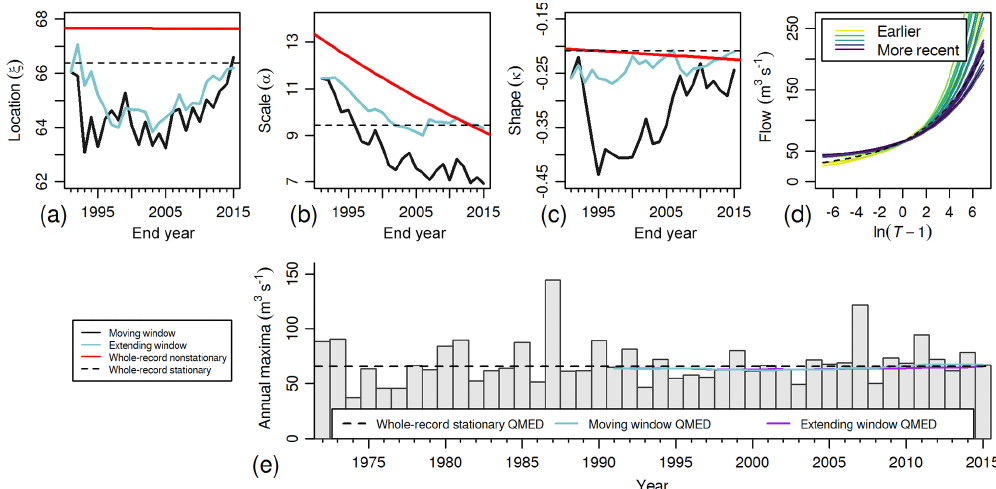
Figure 6. Example of results from fitting stationary and non-stationary parameters on the Agivey at Whitehill in different time windows. (a–c) Stationary parameters computed under moving windows, extending windows, and the whole record, and non-stationary parameters computed on the whole record. (e) AMAX series with QMED moving estimate. (d) Flood frequency curves generated from the moving window analysis and generated from the whole record. Lines on figures (a) , (b) , (c) and (e) are plotted corresponding to the end of the moving or extending